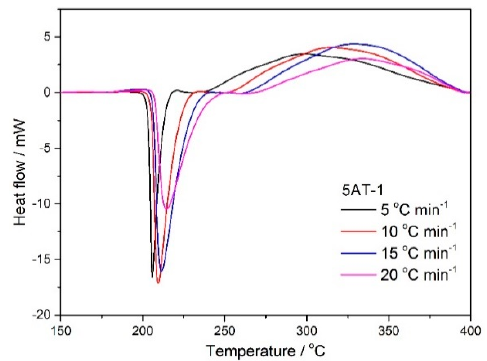
Figure 7. DSC profiles of 5AT–1 using four different heating rates. Figure 7. DSC pro fi les of 5AT–1 using four di ff erent heating rates. Figure 7. DSC pro fi les of 5AT–1 using four di ff erent heating rates.